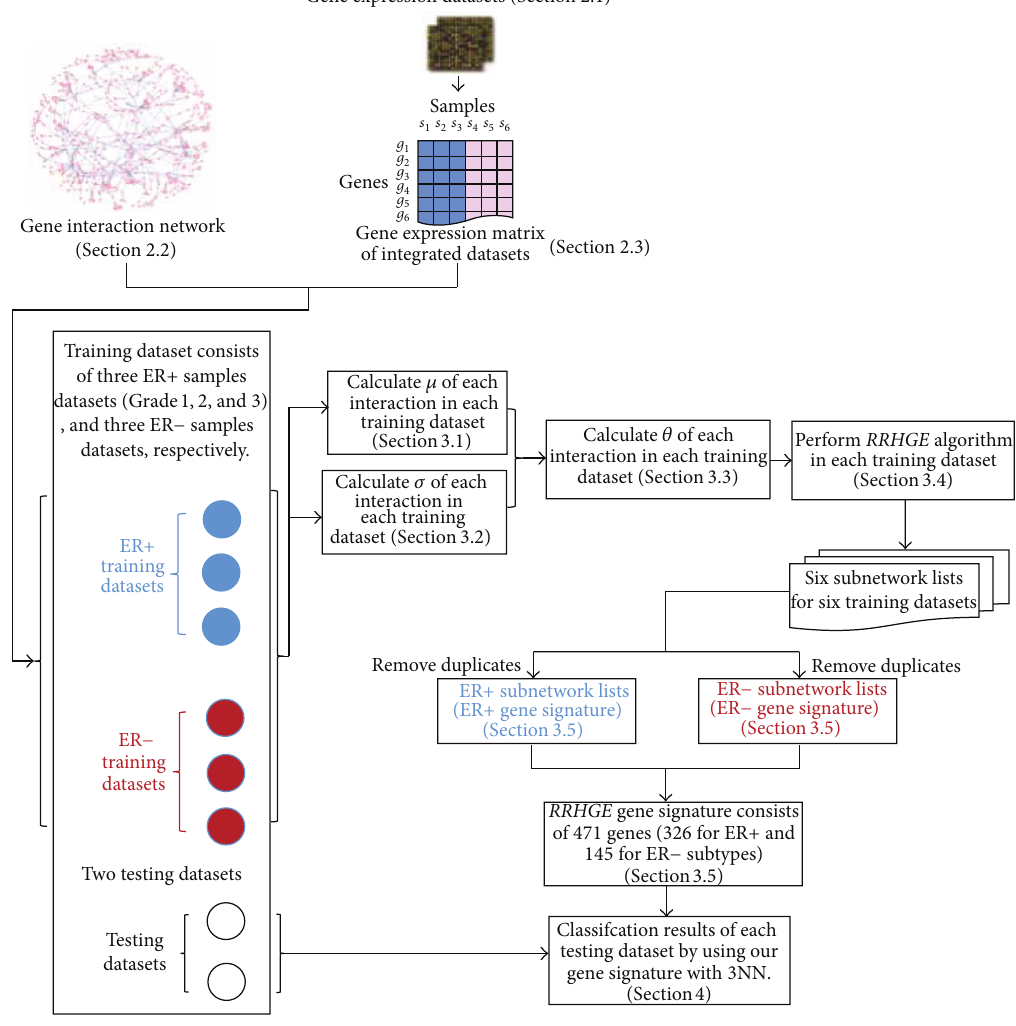
Figure 2: The proposed algorithm workflow. In our study, six training sets were used to generate the robust RRHGE gene signature, and two testing sets were used to classify the ER+/ER − breast cancer samples. The RRHGE gene signature set consists of 471 genes (326 for ER+ and 145 for ER −